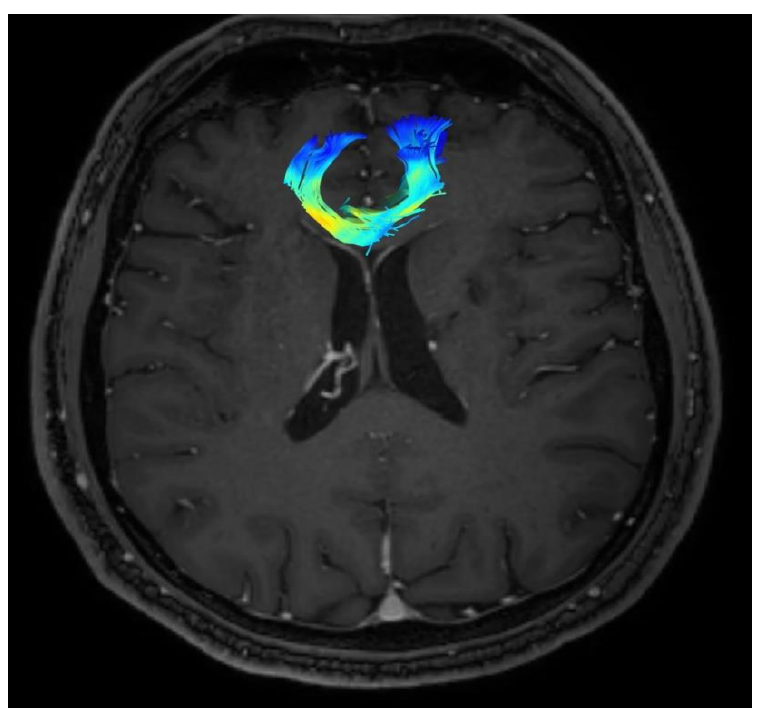
Figure 3. Forceps minor after cingulotomy.